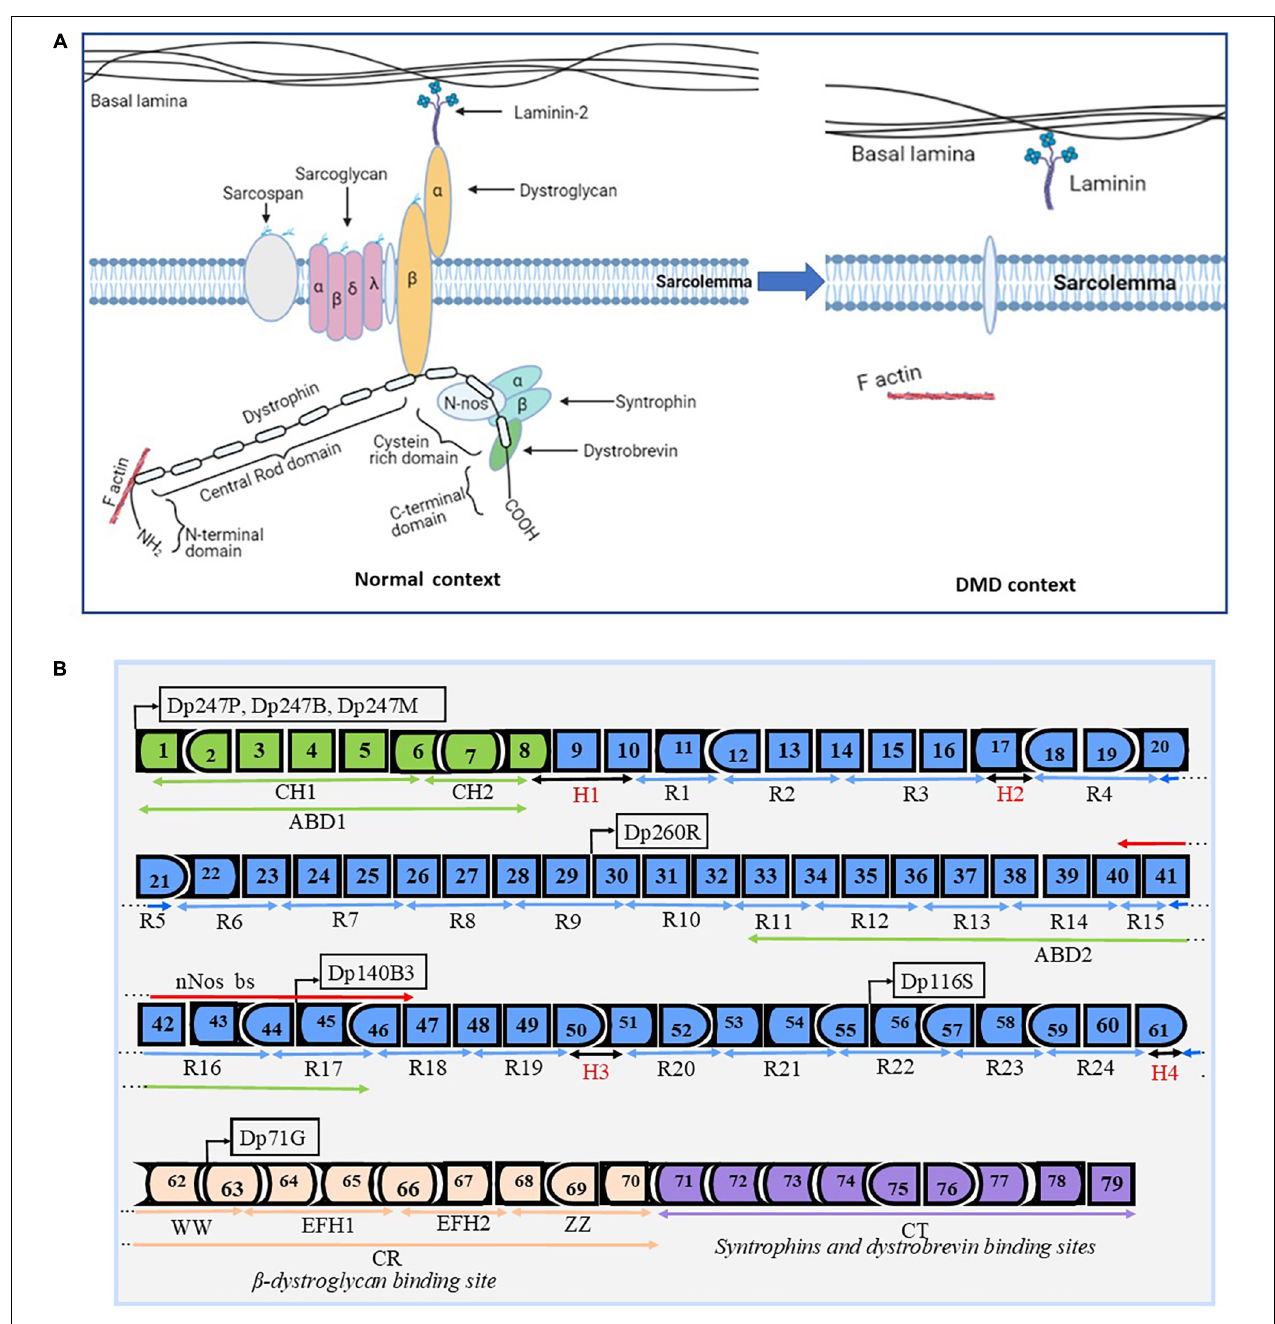
FIGURE 1 | Dystrophin structure and protein associated domain. Design and adapted from the following references (1, 3, 147, 148). Panel (A) represents the basic structure of the dystrophin complex in the normal context and in a DMD context. In the normal context, dystrophin is present under the sarcolemma and is properly attached to other components to form the dystrophin complex. In the DMD context, there is an absence of the dystrophin complex, which results in the absence of the dystrophin complex and in muscle fiber degradation during muscle contraction. Panel (B) depicts the dystrophin gene (exons 1–79) with different functional domains: 1- the N-terminal actin binding domain (ABD1 in green) with its two calponin-homology motifs (CH1 and CH2). This domain is required for the function of the dystrophin protein. 2- The central rod domain (CR in blue color) contains 24 spectrin-like repeats (R1–R24), the normal alignment of this region is fundamental for a correctly functional dystrophin protein. This domain is interrupted and bordered by four proline rich hinge regions (H1, H2, H3, and H4). It also contains the second actin binding domain (ABD2) and the nNos binding site (nNos bs). 3- The Cysteine rich domain contains the WW domain, EF hands, and ZZ domain. This domain serves as the binding site for beta dystroglycan and it is required for a functional dystrophin. 4- The C terminal domain serves as a binding site for syntrophins and the dystrobrevin glycoprotein. This domain is also required for a functional dystrophin. The DMD gene encodes seven different protein isoforms under different tissues specific promoters (Dp427P, Dp427B, Dp427M, Dp260R, Dp140B3, Dp116S, and Dp71G, respectively for cerebellar Purkinje cells, brain, muscle, retina, and Schwann cells).